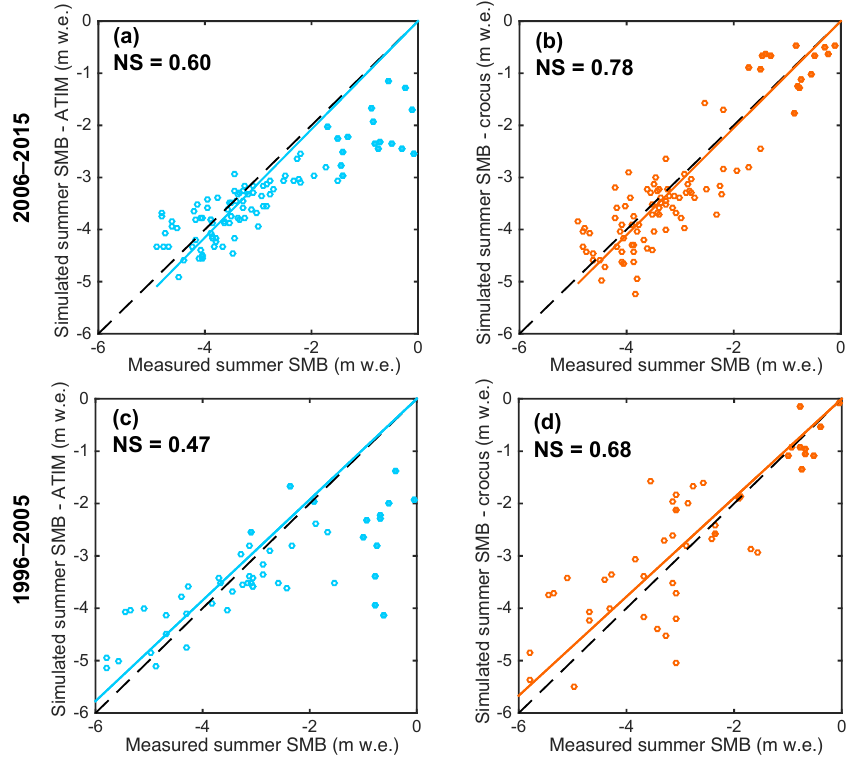
Figure 4. Correlations between simulated – blue (a, c) for the ATI model and orange (b, d) for the Crocus model – and measured summer SMBs at each stake of Saint-Sorlin Glacier over the 2006–2015 period (a, b) and the 1996–2005 period (c, d) . Circles represent measurements in the ablation area and solid dots represent measurements in the accumulation